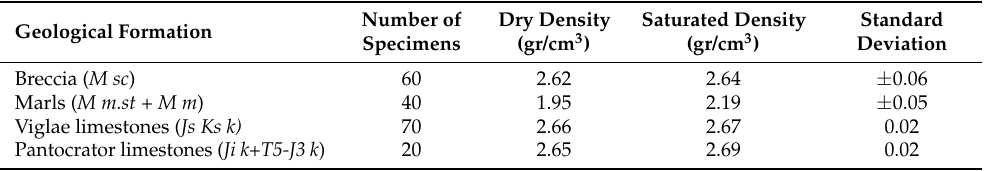
Table 2. Density values of each geological formation of Lefkada and Corfu towns.